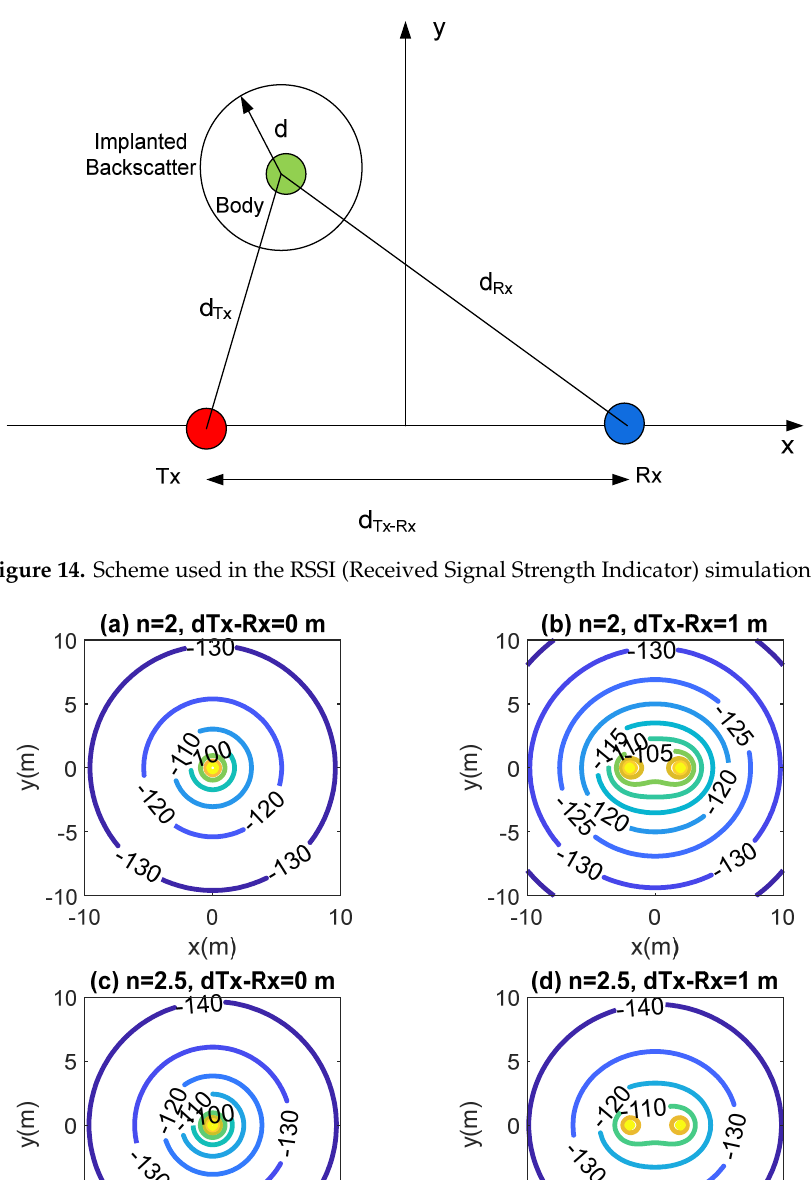
Figure 15. Simulated RSSI as a function of the location of the implanted backscatter assuming a depth of 5 cm inside the body for the monostatic case (d Tx − Rx = 0 m) and bistatic case (d Tx − Rx = 1 m). Path loss exponential factor n 1 = n 2 = 2 and n 1 = n 2 = 2.5.